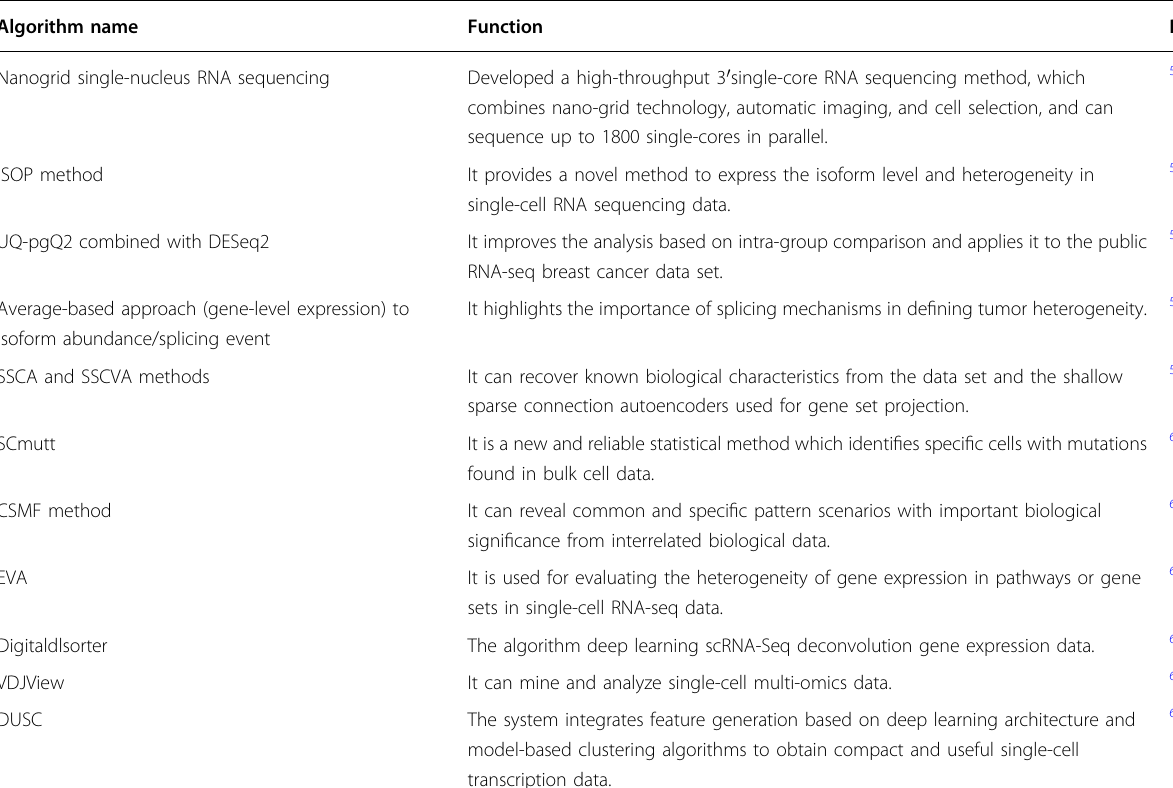
Table 1 Methods for analysis sc-RNA sequencing data in the breast